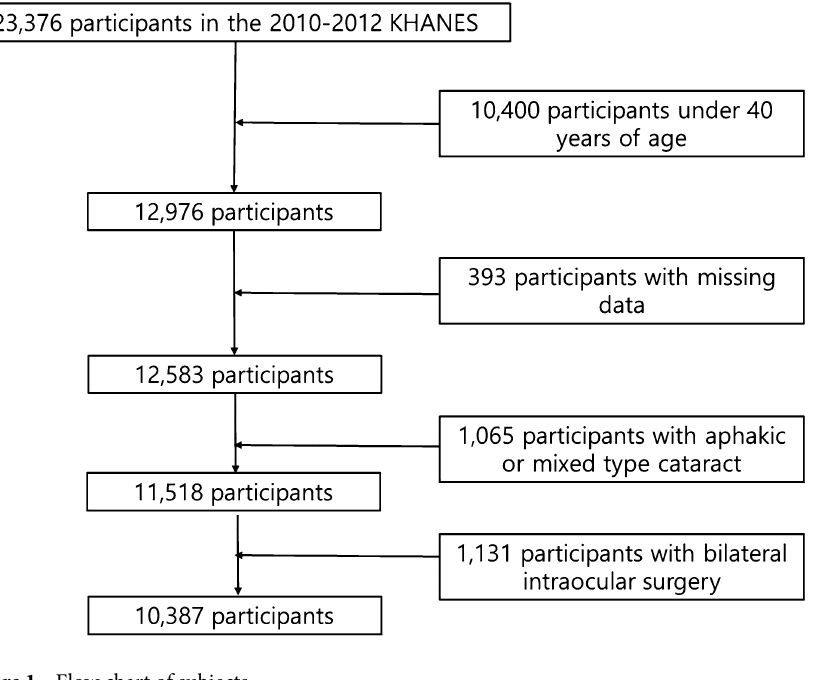
Figure 1. Flow chart of